Question: What type of chart is this?
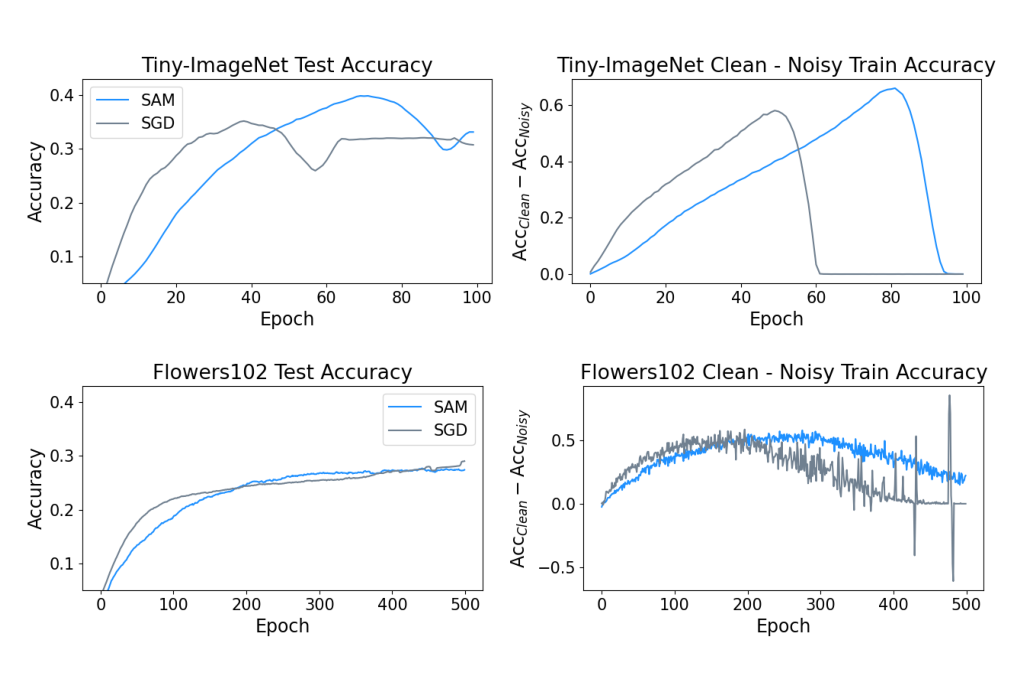
Answer: line